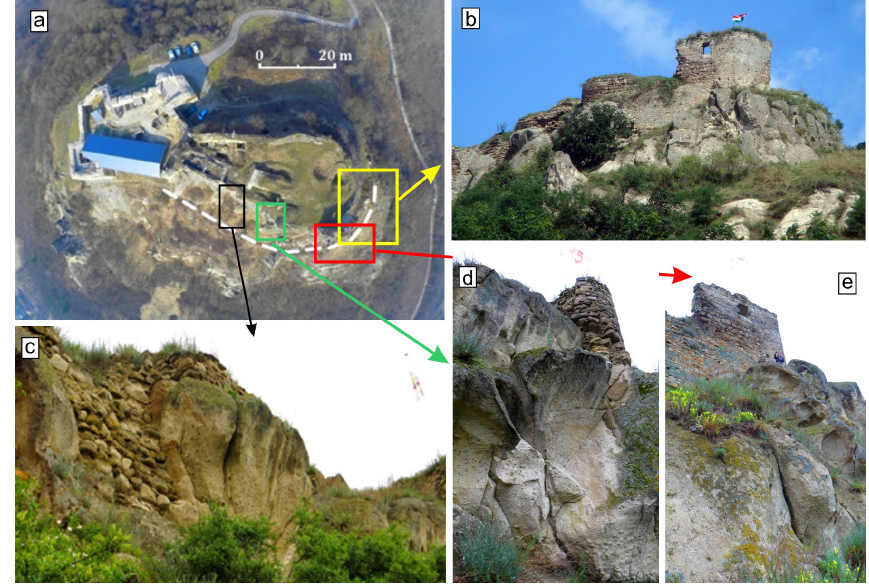
Figure 2. Studied southern cliff faces: (a) image of the castle obtained by RPAS with marked details, (b) distant view of the eastern part of the cliff section, (c) steep cliffs dissected by joints, (d) vertical to subvertical cliff face with steep joints and traces of rockfall and (e) weathered rounded cliff with larger